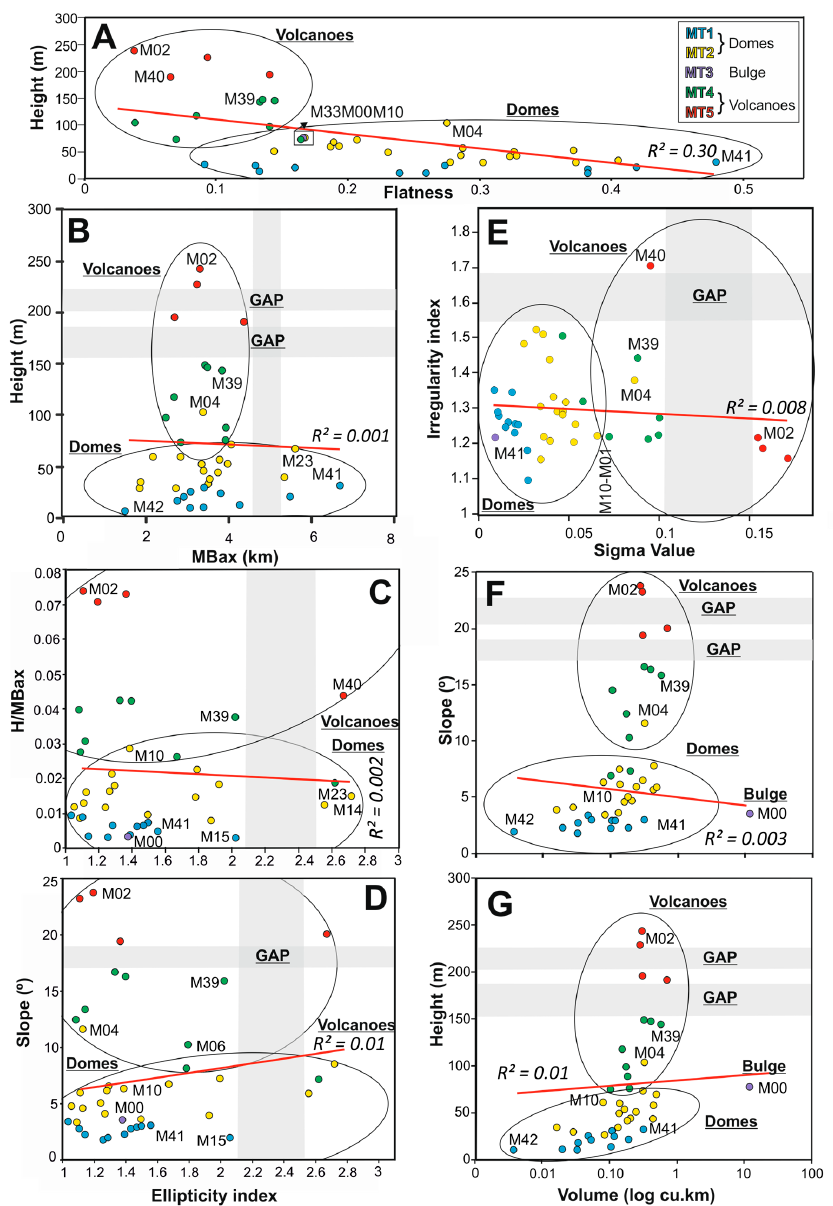
Figure 5. XY scatter plots of the main variables for the forty edifices (n: 40). ( A ) Flatness (X) vs. Height (Y); ( B ) Basal length (X) vs. Height (Y) excluding M00 that is considered an outlier; ( C and D ) Ellipticity index (X) vs. Height/Basal length (Y) and Slope (Y), respectively; ( E ) Sigma value (X) vs. Irregularity index (Y); and ( F and G ) Logarithmic (log 10) Volume (X) vs. Slope (Y) Height and (Y), respectively. The five morphometric edifice types are shown and some mismatched edifices are highlighted. The red lines indicate the trend line of each correlation and the R 2 coefficient is displayed next to them. The ellipses indicate the natural tendency of the edifice types to cluster, and gaps in the distribution are highlighted by shaded regions.